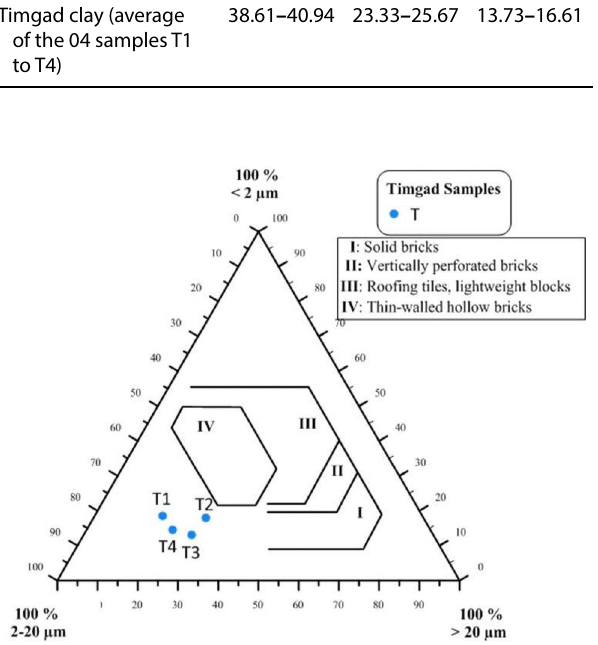
Fig. 13 Particle size data projection in the Winkler diagram